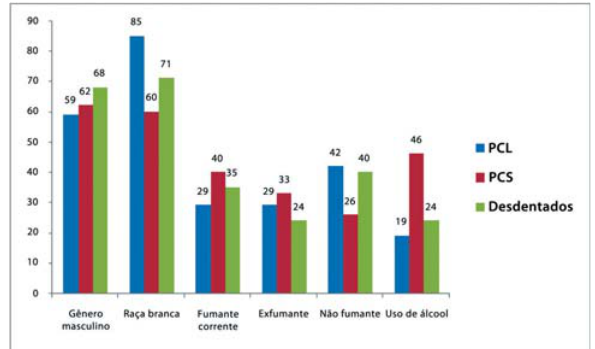
Fig.1 - Características demográficas dos pacientes com doença coronariana com e sem periodontites crônicas. PCS = Periodontite crônica grave; PCL = Periodontite crônica leve